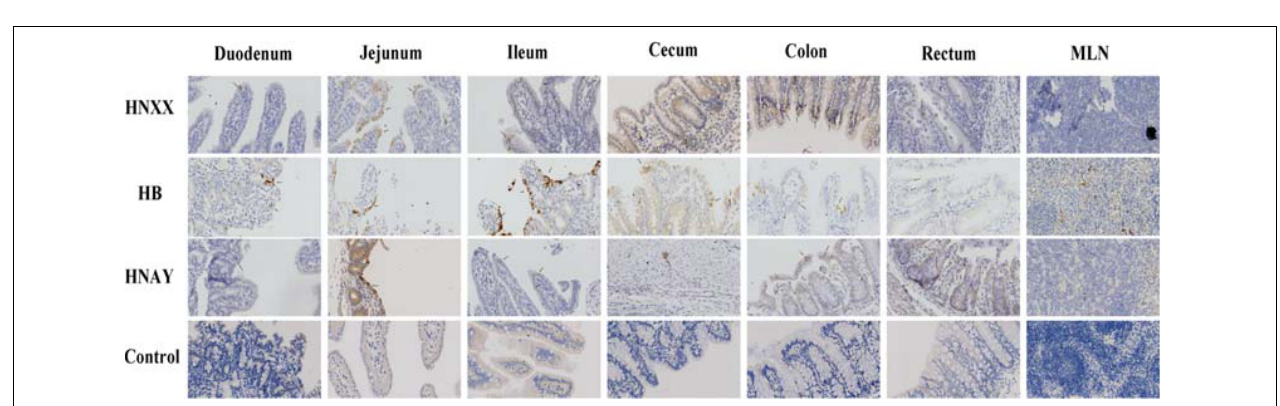
FIGURE 7 | Pathogenicity analysis of PEDV isolates in new-born piglets. (A) Survival rate of piglets in each group. (B) The severity of diarrhea was scored based on clinical examination; 0 = normal and no diarrhea; 1, mild and fluidic diarrhea; 2, severe watery diarrhea; with scores of 1 or more considered diarrheic. (C) Fecal virus shedding in PEDV-challenged piglets by RT-qPCR. (D) Microscopic damage in Jejunum in piglets (Original magnifications: × 20). (E) Further analysis of jejunum villous high: crypt depth ratios (VH:CD).